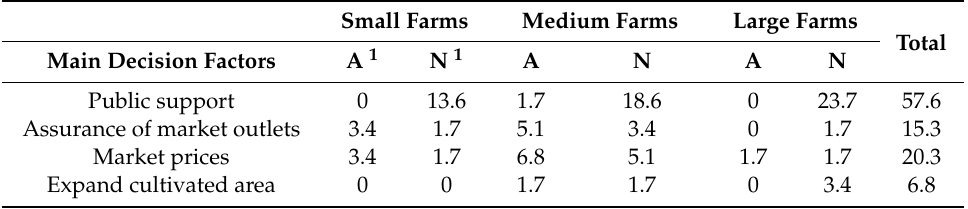
Figure 5. Relative frequency (%) of farmers’ willingness to adopt Organic Farming by: ( a ) the farm size, (A ffi rmative, blue; Negative, orange), and ( b ) the overall responses. Farm size: Small (lower than 25 m 2 ), Medium, Large (over 8.5 ha). Table 5. Relative frequency (%) of main decision factors governing farmers’ willingness to adopt organic farming, by farm